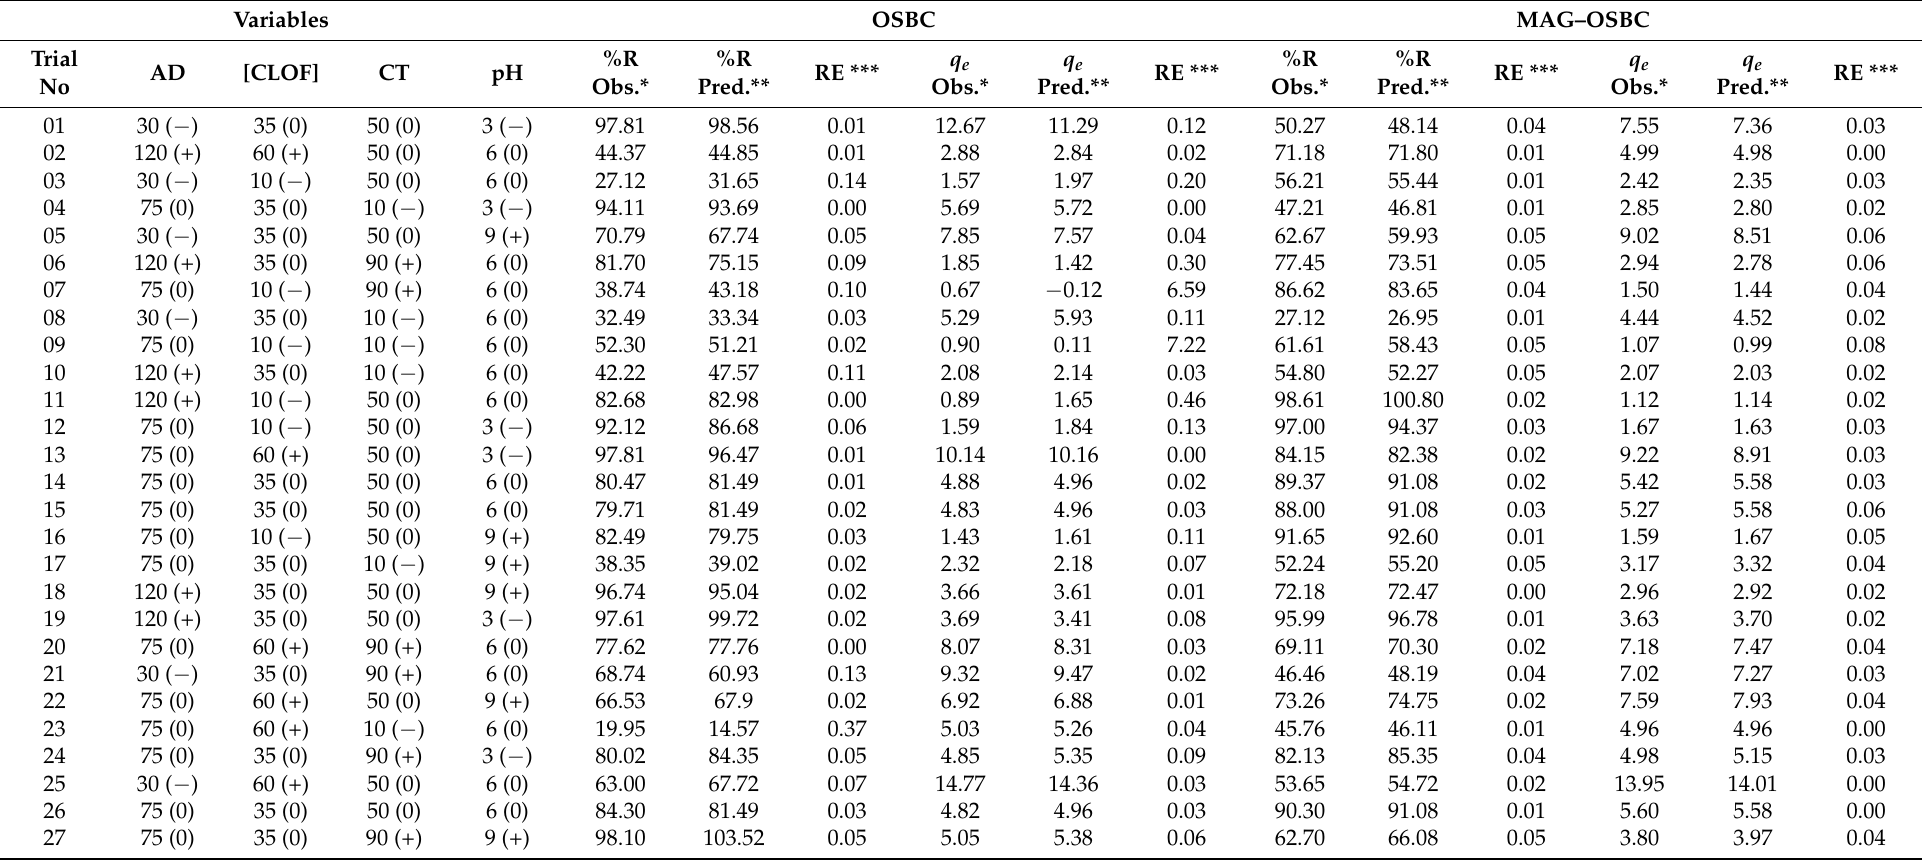
Table 3. Experimental setup using Box – Behnken (BB) design. Observed and predicted values for %R and q e , as well as the relative error (RE), are shown.